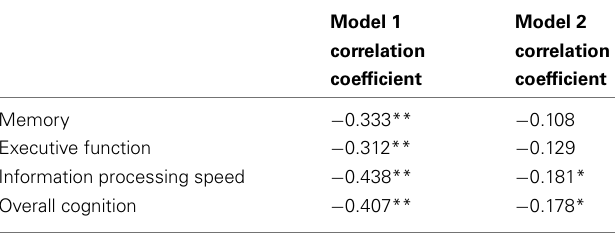
Table 3 | Correlation analyses between total burden of cSVD and cognitive